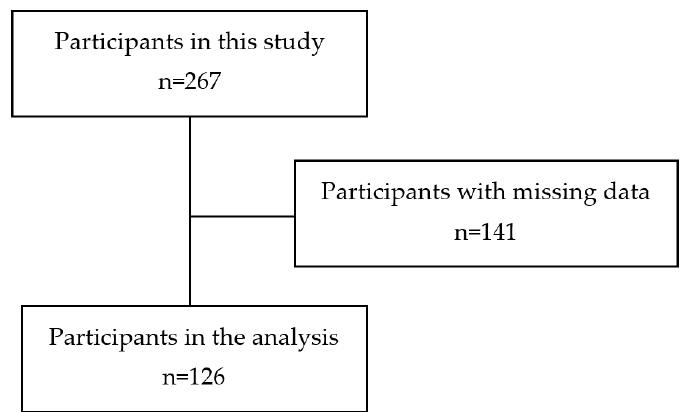
Figure 1. Flow chart of participant